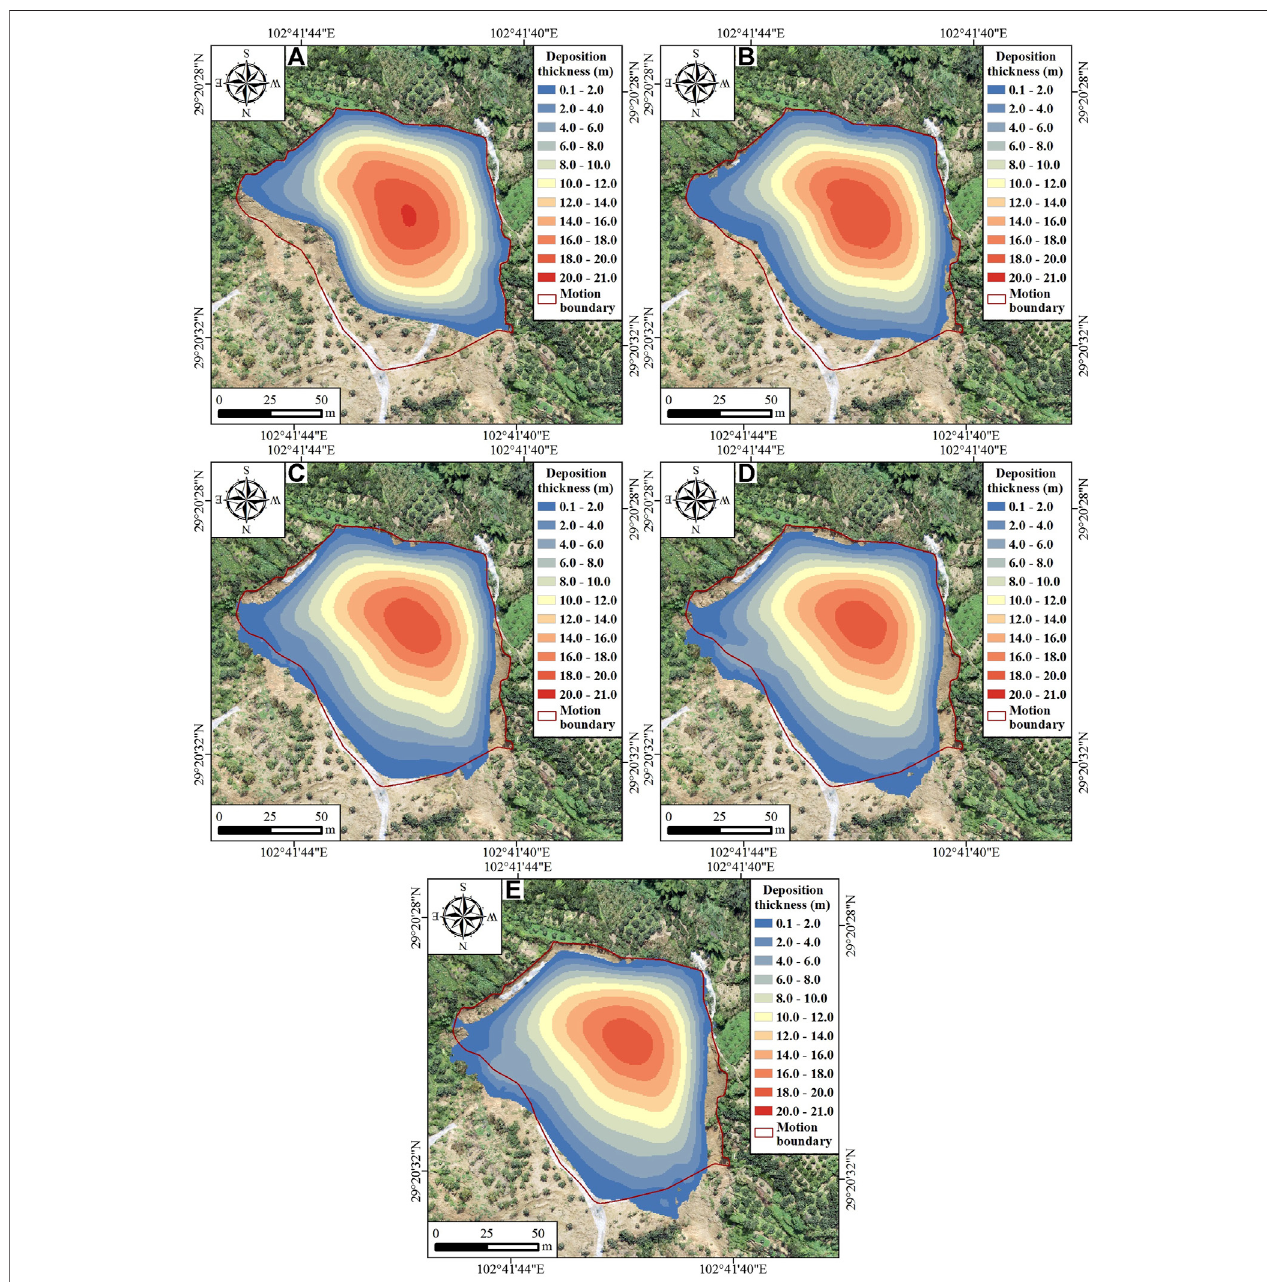
FIGURE 4 | Thickness of the initial landslide at (A) t (cid:2) 0 s, (B) t (cid:2) 2 s, (C) t (cid:2) 4 s, (D) t (cid:2) 6 s, and (E) t (cid:2) 8 s.